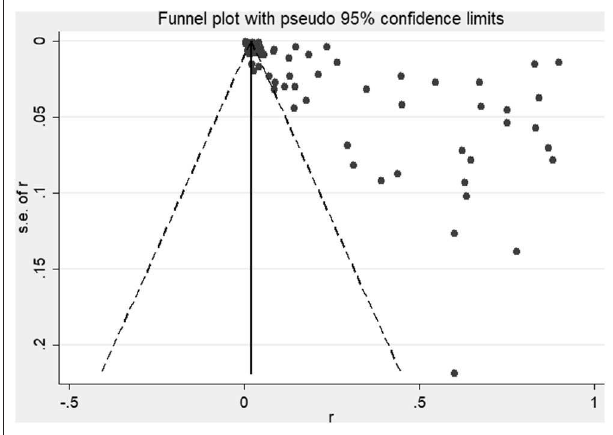
FIGURE 2 | Heterogeneity among the included studies. Dots represent individual studies.